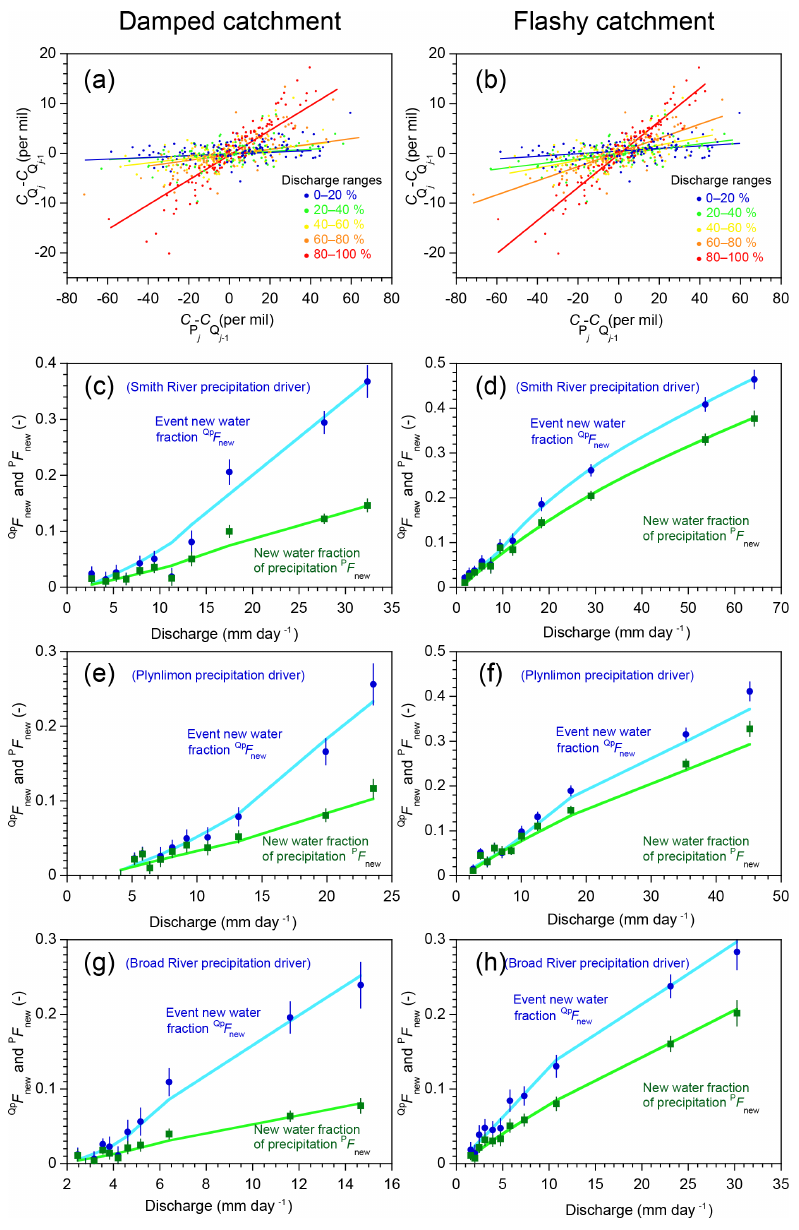
Figure 6. Variations in new water fractions across ranges of discharge. (a, b) Relationship between tracer concentrations in precipitation and streamflow in the benchmark model run shown in Fig. 1, stratified by percentiles of the frequency distribution of discharge, for damped and rapid response parameter sets. In these coordinates, the slopes of the regression lines through the ensembles of points estimate their average event new water fractions Q p F new (Eq. 10; Sect. 2.3). (c–h) Variation in new water fractions across discharge bins in the benchmark model. Dark blue and green symbols show estimates of the event new water fraction of discharge ( Q p F new ) and the forward new water fraction (fraction of precipitation appearing in same-day streamflow, P F new , Eq. 21) for each decile of the daily discharge distribution (the leftmost 10 points) and the uppermost 5% (the rightmost point). Error bars show standard errors, where these are larger than the plotting symbols. Light blue and light green lines show the corresponding true new water fractions measured by age tracking in the benchmark model. The three rows ( c–d , e–f , and g–h ) show catchment response to three different precipitation climatologies (Smith River, Plynlimon, and Broad River), for both the damped response parameter set (c, e, g) and the flashy response parameter set (d, f, h) . The new water fractions Q p F new and P F new vary strongly with discharge. Ensemble hydrograph separation accurately estimates both Qp F new and P F new across the full range of discharge for all three forcings and both parameter